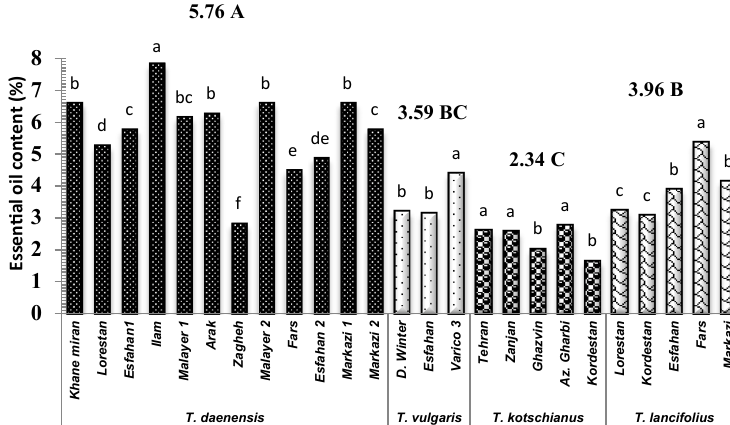
Fig. 2: Mean essential oil content in different Thymus ecotypes and